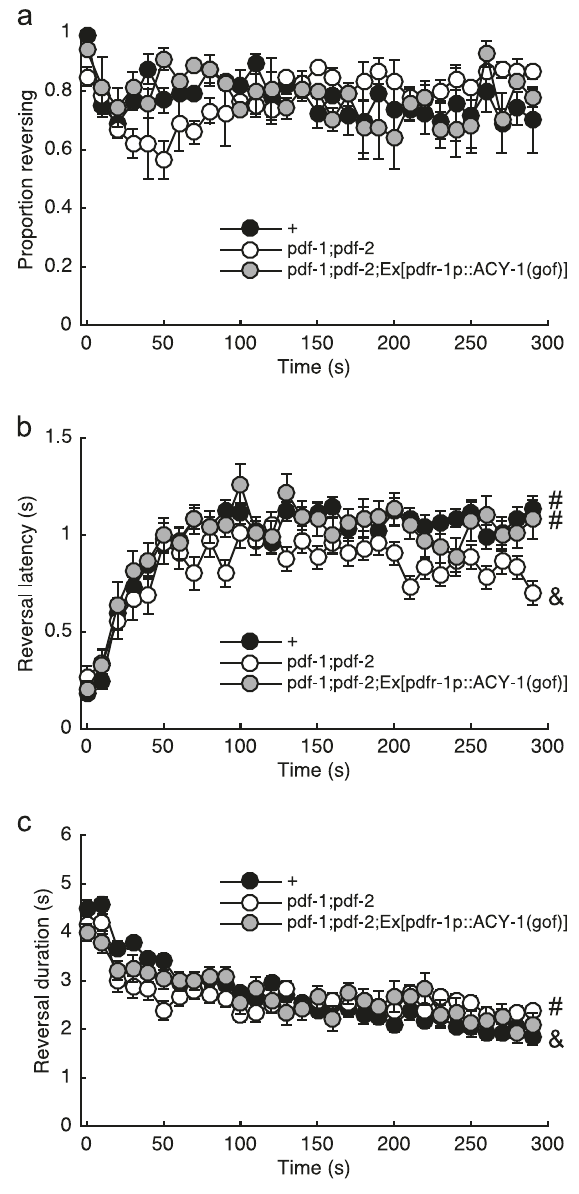
Fig. 4 PDFR-1 signals through cAMP to promote habituation. Proportion of the population reversing ( a ), reaction time ( b ), and response duration ( c ) to each of 30 2 s light pulses administered at 0.1 Hz. Mean ± SEM. ‘ # ’ and ‘ & ’ denote signi fi cantly different groups based on the response to the fi nal stimulus. N = 3